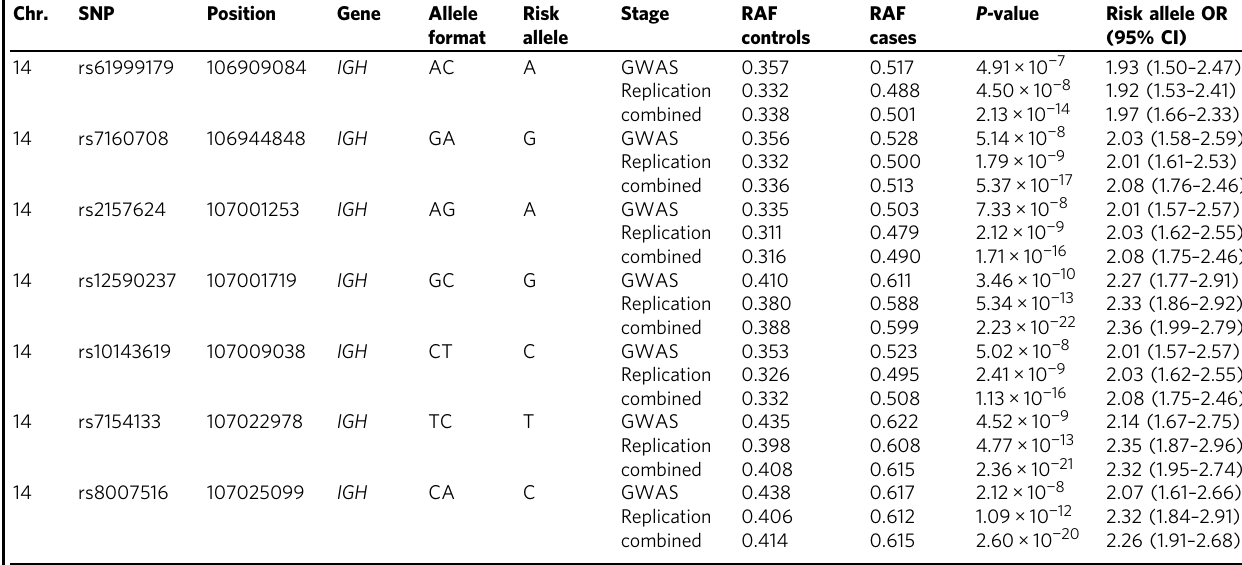
Table 1 Association analyses of the seven SNPs achieving genome-wide signi fi cance in the joint analysis for anti-PEG IgM